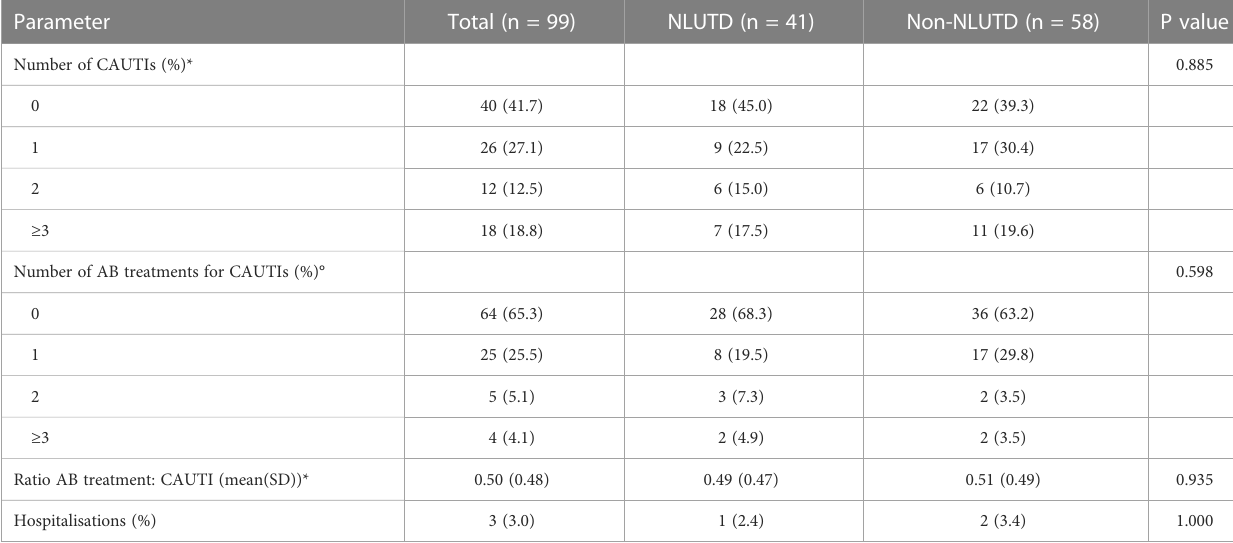
TABLE 2 Safety and ef fi cacy of bladder irrigation with tap